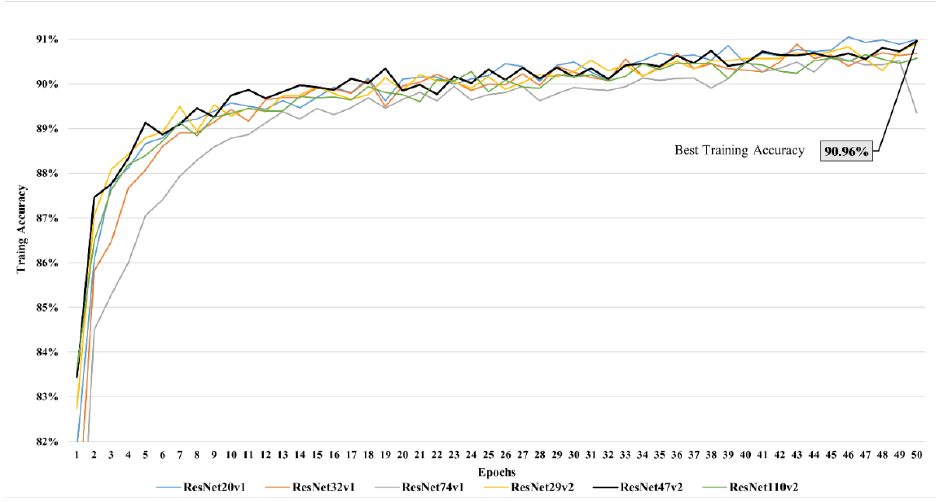
Figure 12. Training accuracy curves for the various ResNet models. The confusion matrices in Figure 16 show the comparison of each class’s accuracy for the best proposed model (ResNet version 2 with 47 layers). The left confusion matrix shows the percentage accuracies for each class, and the right confusion matrix shows correctly classified grain images for each class. The results in the confusion matrix indicate that the classes C1 and C5 achieved higher accuracies as they had more grain images for the